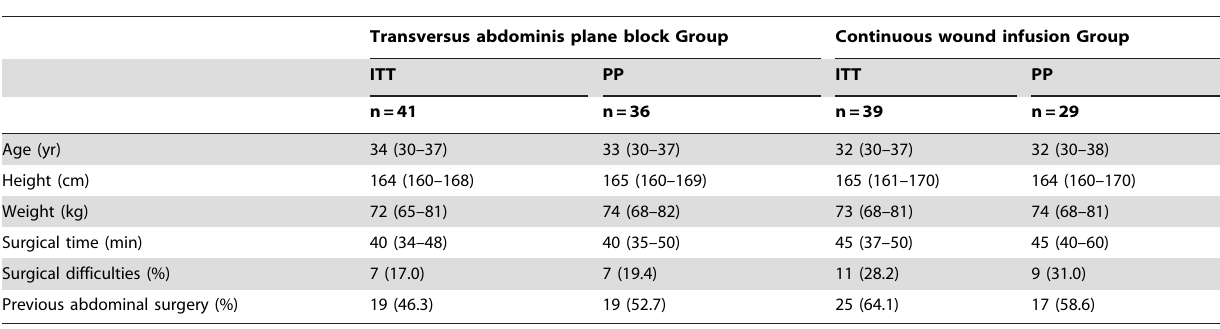
Table 1. Characteristics of study patients, presented as mean [1 st and 3 rd interquartile] and as numbers (%).